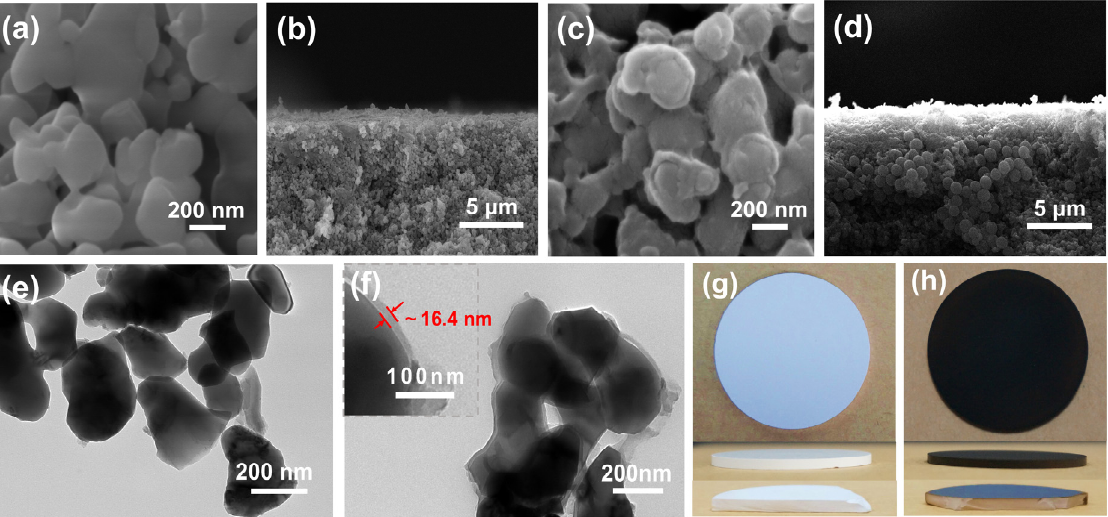
Figure 3. Images of ceramic membranes: ( a , b ) SEM images of ACM and ( c , d ) C@ACM (( a , c ): surface; ( b , d ): cross-section); ( e ) TEM images: alumina particles; ( f ) carbon-coated alumina particles; ( g , h ) Photography images of ACM and C@ACM (1-top; 2-side; 3-cross-section). After the modification, the color of the membrane changed from white to